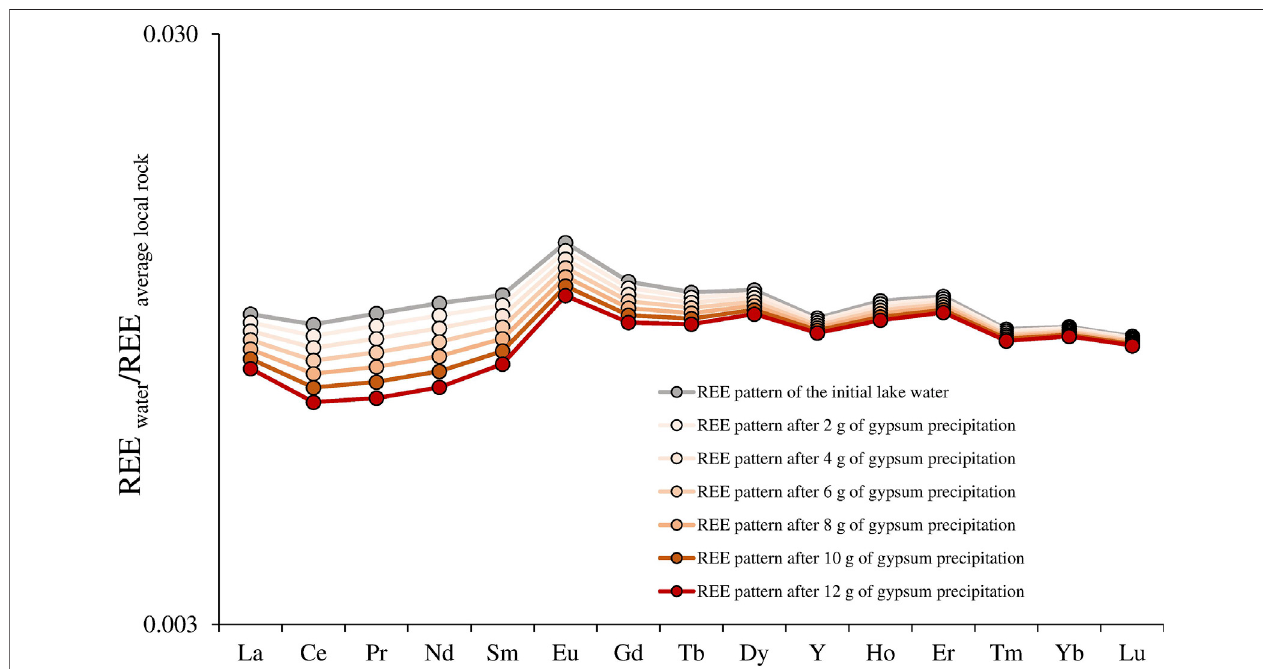
FIGURE 12 | REE concentrations in lake water normalized to the average local rock (Carr et al., 2013) after 2, 4, 6, 8, 10, and 12 g of gypsum precipitation. The average REE concentration [REEi]water was used as the initial point and calculated considering the samples of stage 1 characterized by (La/Pr) N-local rock and (LREE/HREE) N-local rock ratios close to 1. REE concentrations removed from the gypsum precipitation were subtracted to the [REEi] water and plotted.